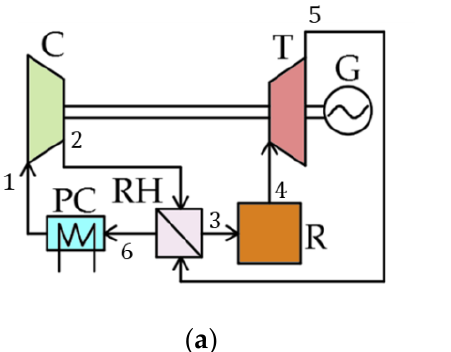
Figure 2. Supercritical CO 2 Brayton cycle with regeneration: ( a ) schematic diagram; ( b ) T – S diagram [12]. R — reactor; T — turbine; G — generator; RH — regenerative heat exchanger; PC — precooler; C — compressor.